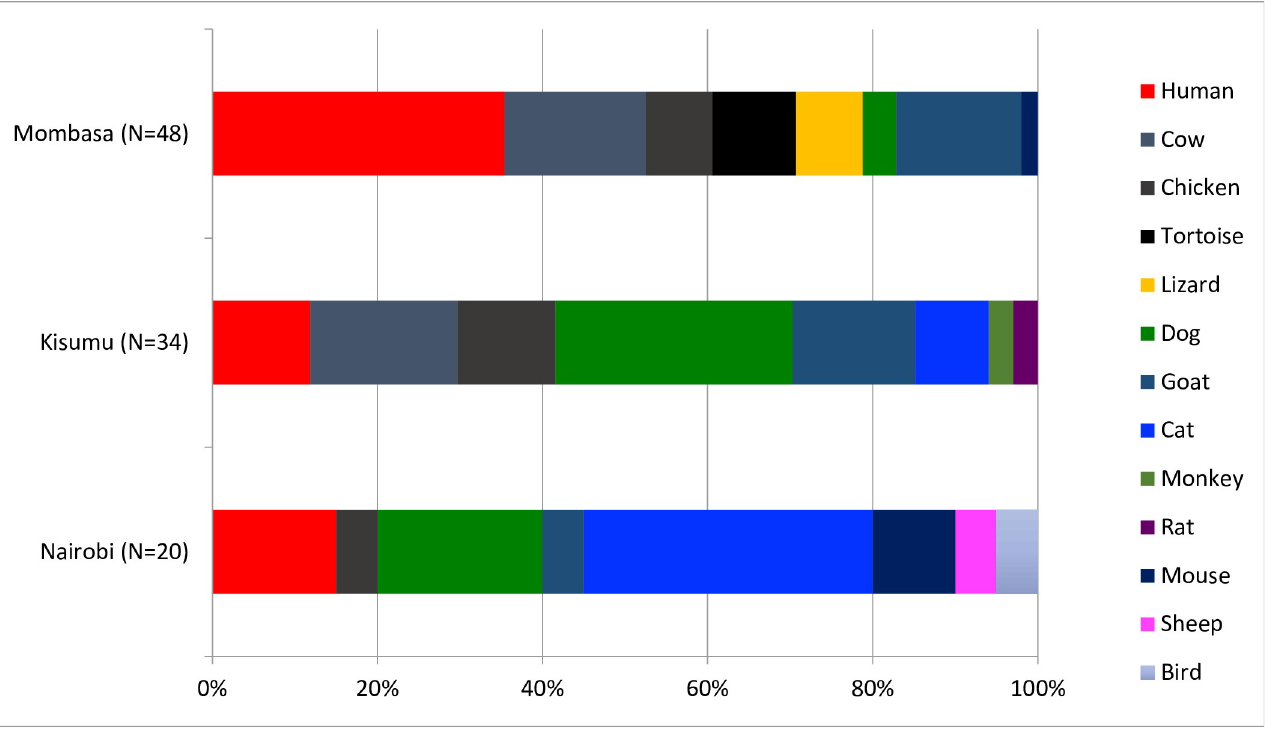
Fig 2. Host blood meal sources for Aedes aegypti mosquitoes collected from Mombasa, Kisumu and Nairobi from October 2014 to June 2016.